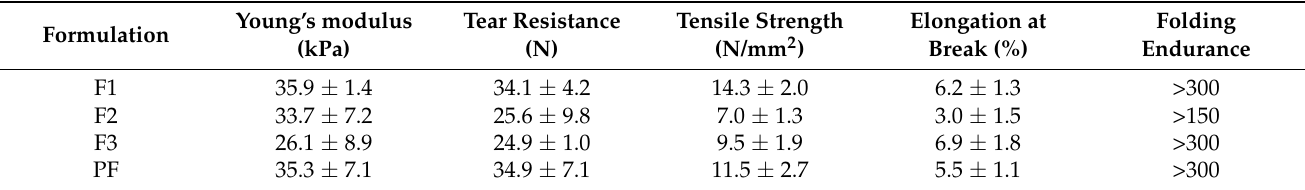
Table 3. Physicomechanical characteristics of the films: Young’s modulus, tear resistance, tensile strength, elongation at break (mean ± SD, n ≥ 6), and the values of folding endurance (n = 3). Formulation